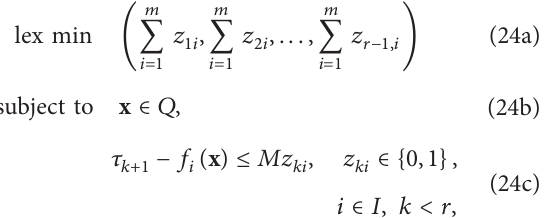
𝑘 ℎ ( y ) with ℎ ( y ) 𝑙 𝑘 𝑙=1